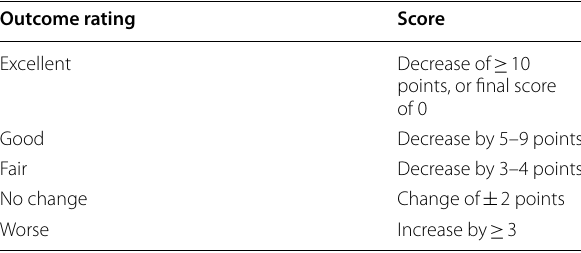
Table 2 Criteria for evaluating the clinical results according